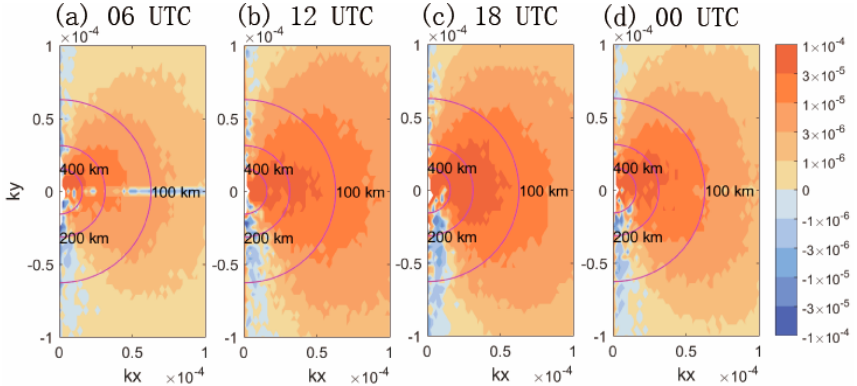
Figure 6. Time-averaged zonal momentum flux power spectra at 30 hPa in horizontal (kx, ky) wavenumber space for 12-h forecast results at ( a ) 06 UTC, ( b ) 12 UTC, ( c ) 18 UTC and ( d ) 00 UTC.